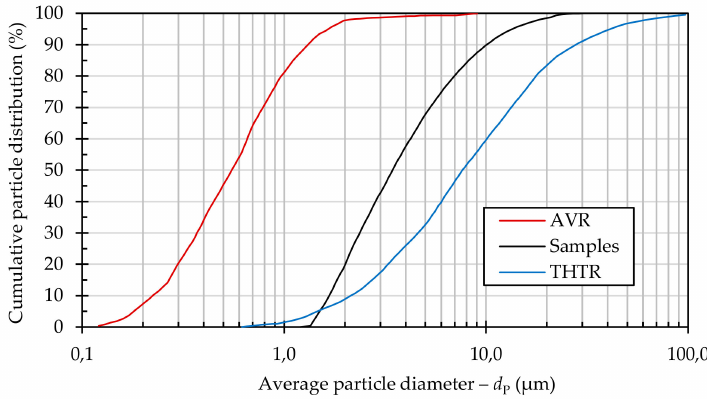
Figure 1. Cumulative particle size distribution of